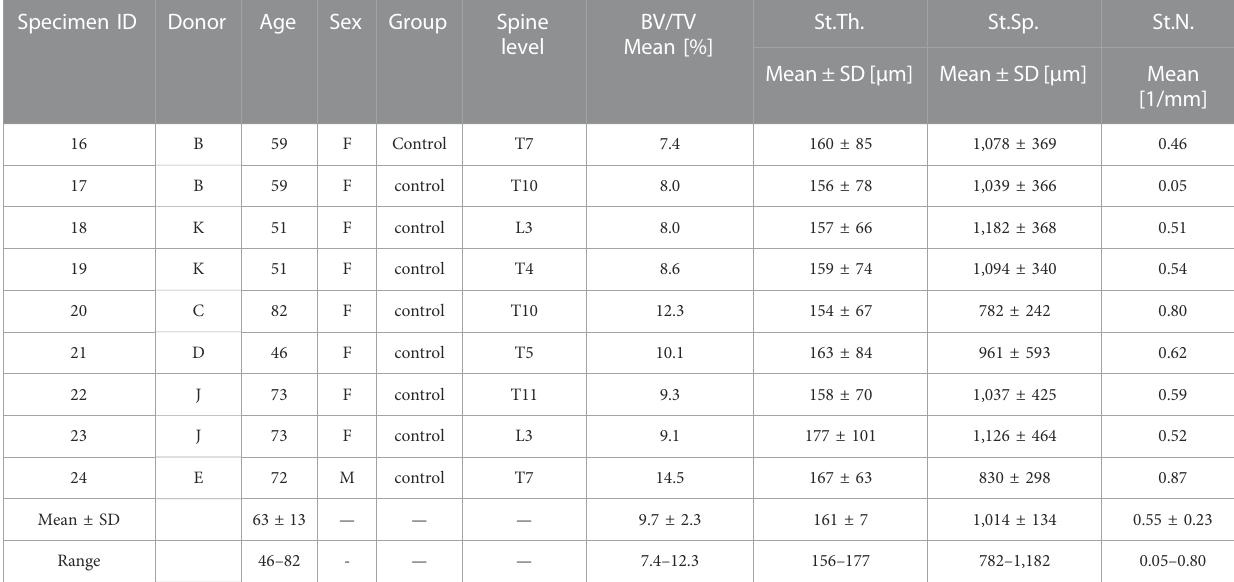
TABLE 2 Main microstructural parameters calculated for each control vertebra. Specimen